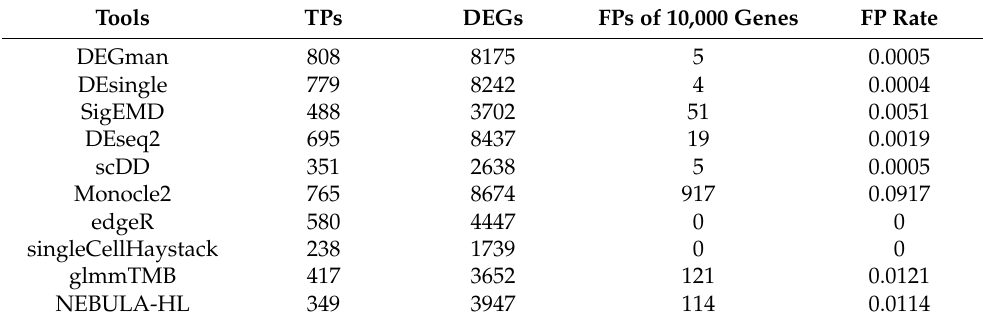
Table 2. Numbers of predicted DEGs and the TPs of the 1000 gold standard genes for the ten tools, and numbers of detected DEGs (FPs) by using negative control real data. Adjusted p -value <